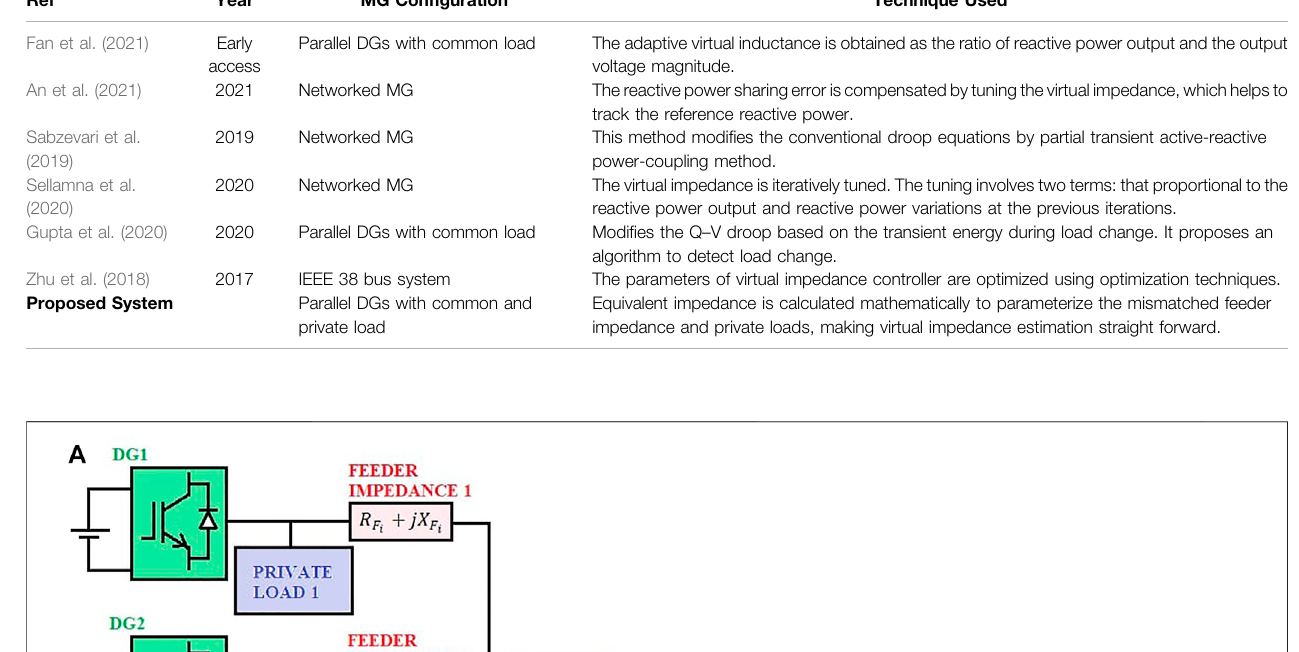
Frontiers in Energy Research |